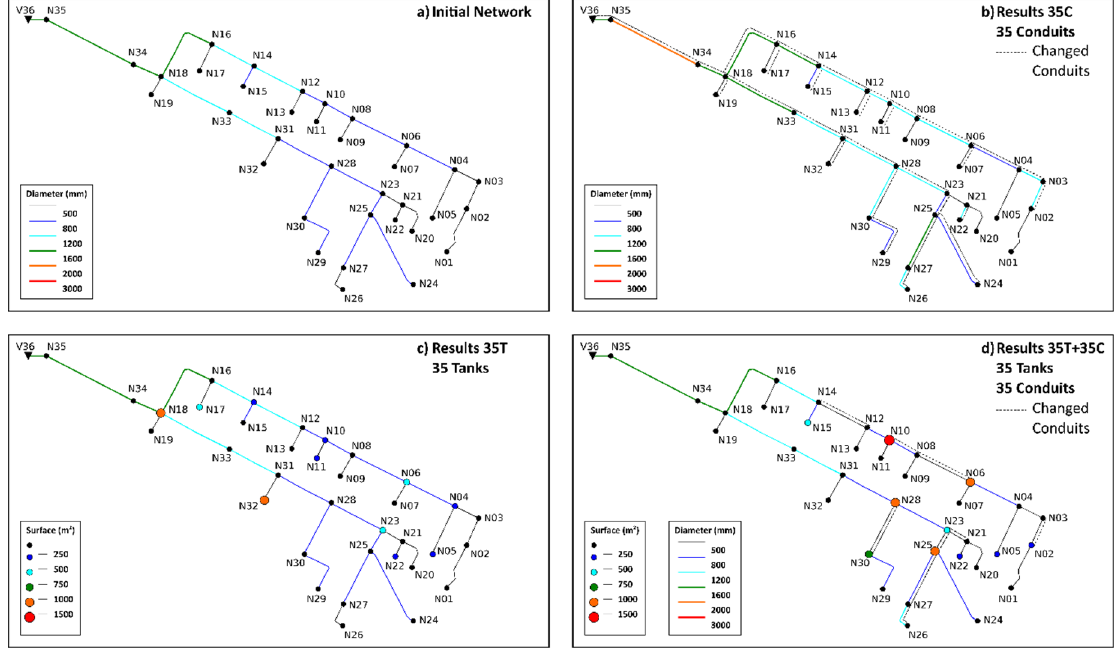
Figure 6. Original network ( a ) and solutions for no flooding for ( b ) Scenarios 1, ( c ) 2 and ( d ) 3. Changed pipes are represented as dashed lines.